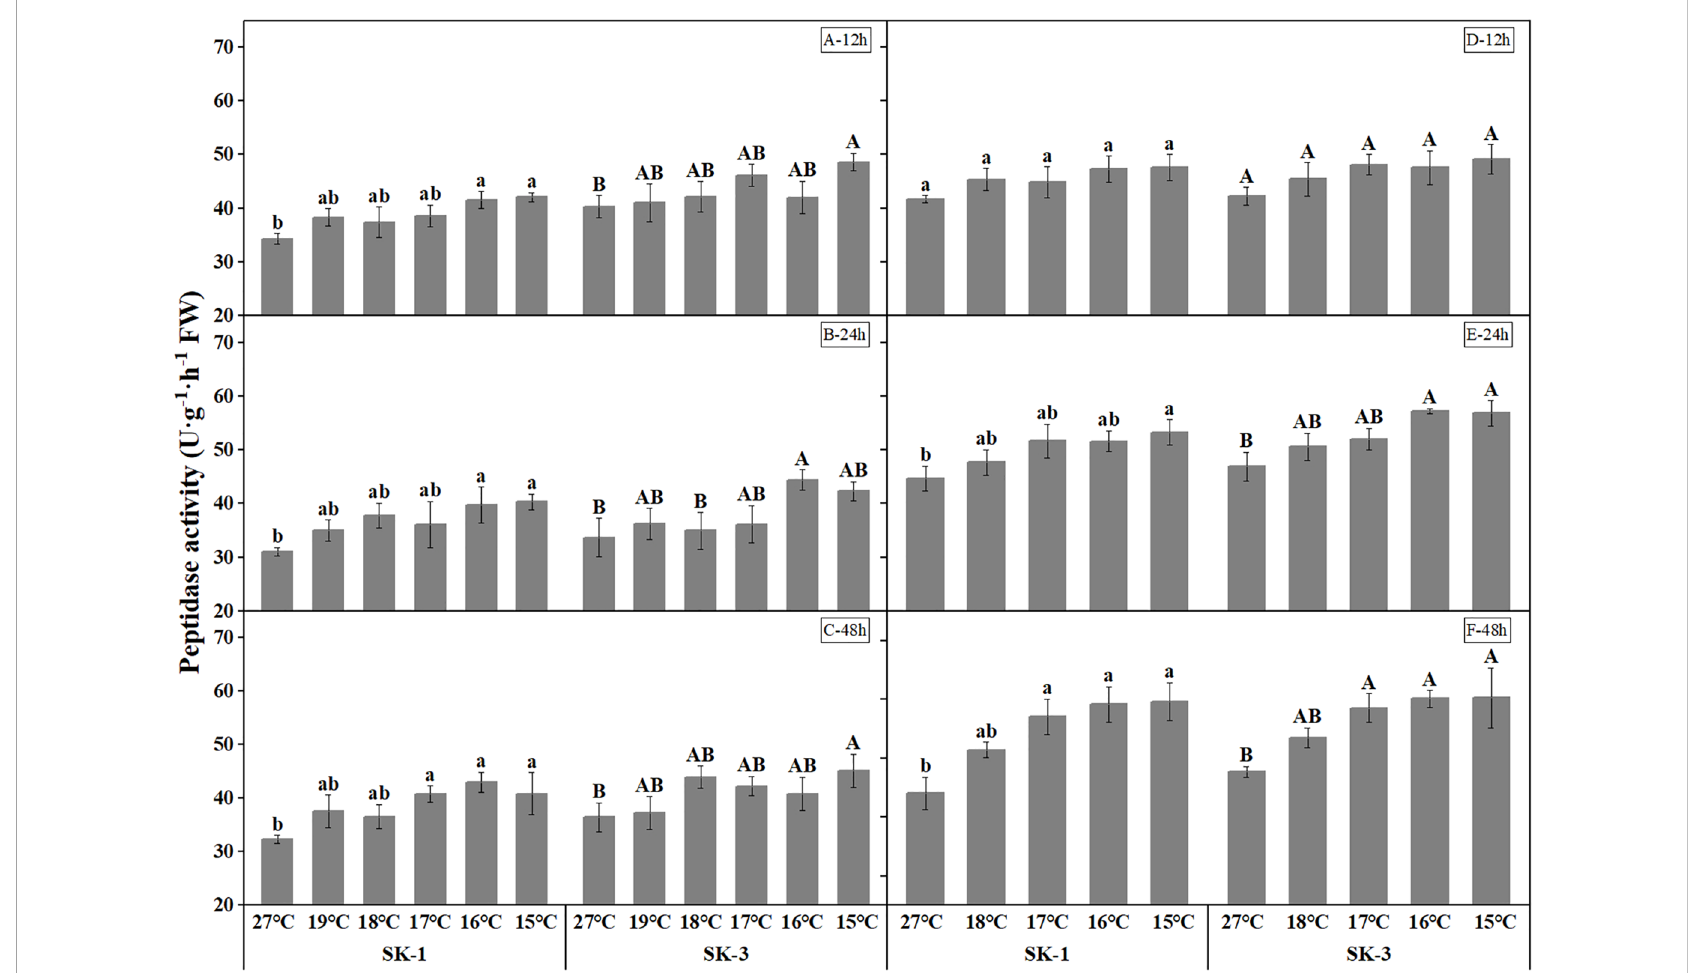
FIGURE 12 Effect of low temperature stress on peptidase activity in cotton squares in 2020 ( A-C : 12h, 24h, 48h stress) and 2021 ( D-F : 12h, 24h, 48h stress). FW represents fresh weight. Different lowercase letters indicate the signi fi cant differences between the treatments of the variety SK1, and different capital letters indicate the signi fi cant differences between the treatments of the variety SK3